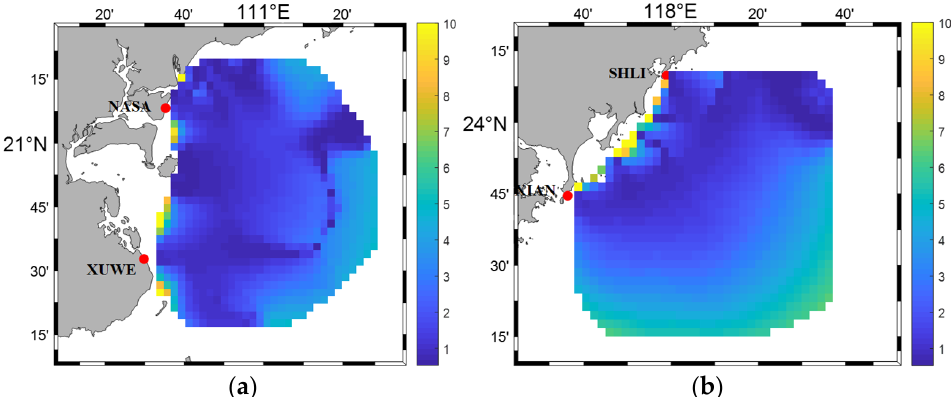
Figure 2. Geometric dilution of precision (GDOP) for the current maps shown in Figure 1a,b. GDOP values greater than 10 are set to 10 for better contrast.